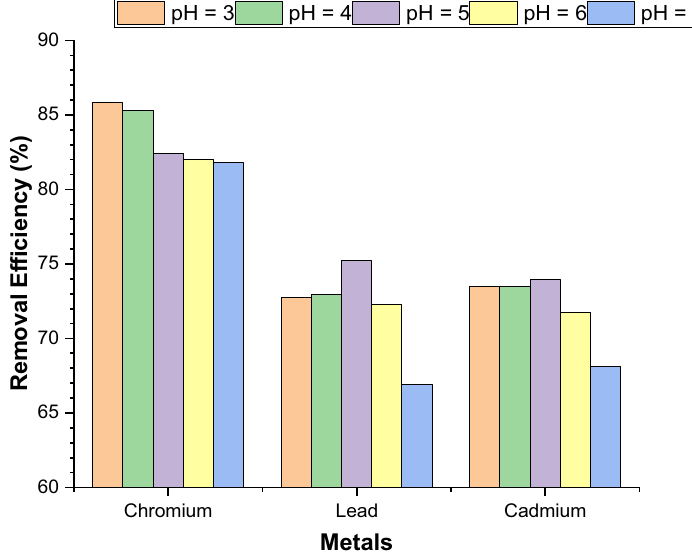
Figure 6. Effect of pH for removal of Cr(VI), Pb(II), and Cd(II) by